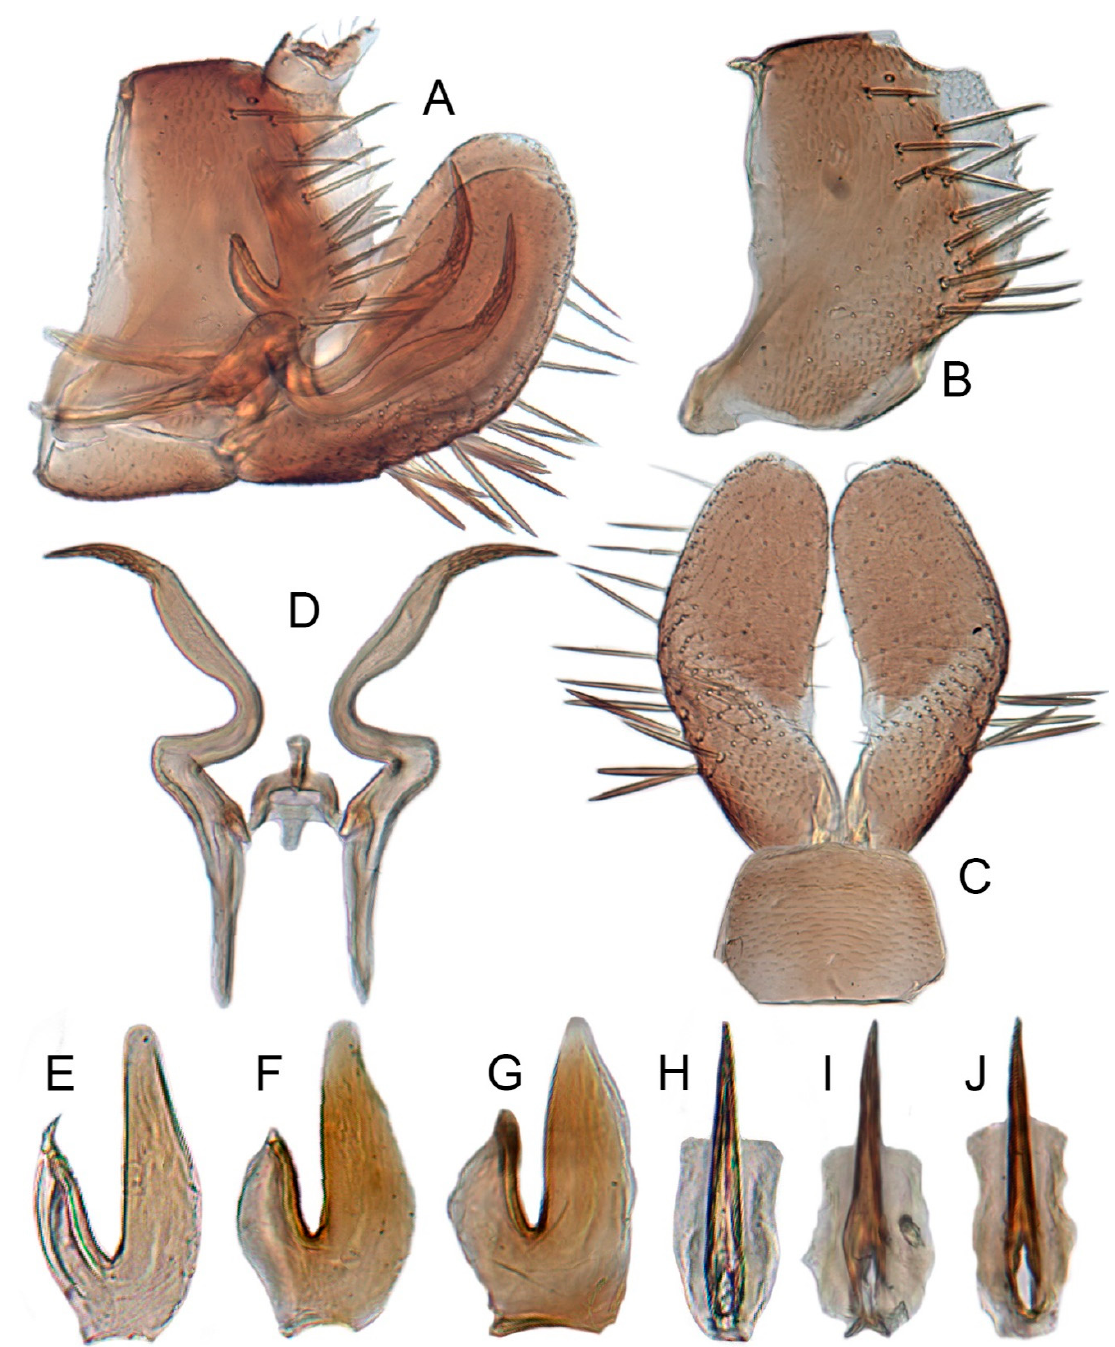
Figure 7. Xestocephalus nonattribus sp. nov. ( A ) Male genital capsule, lateral view; ( B ) pygofer lobe, lateral view; ( C ) subgenital plates and valve, ventral view; ( D ) style and connective, ventral view; ( E – G ) aedeagus, lateral view; ( H – J ) aedeagus, posterior view.